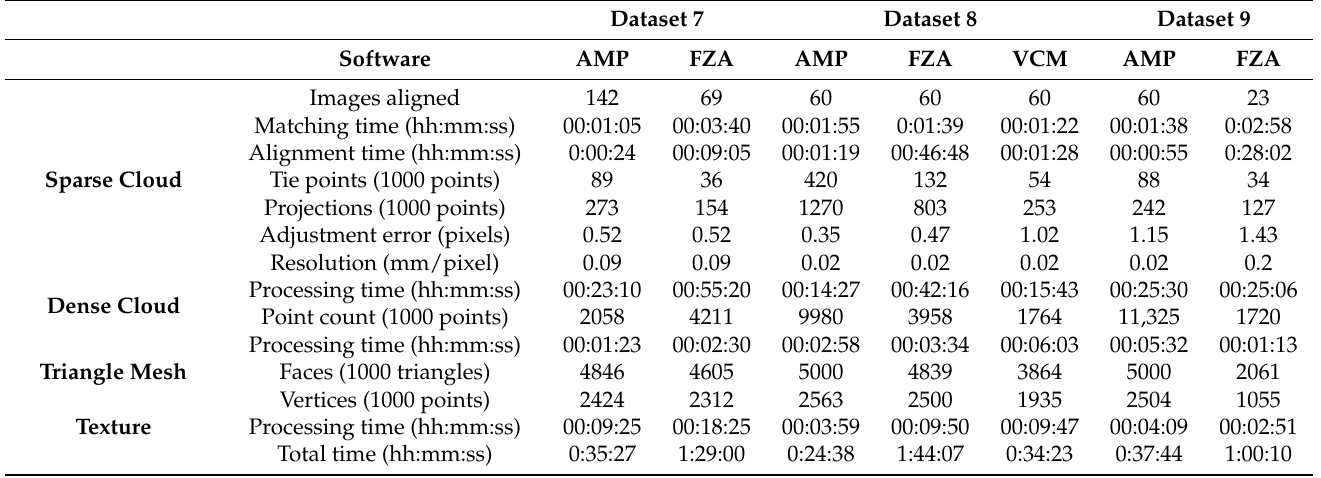
Table 7. Photogrammetric results, datasets 7–9.